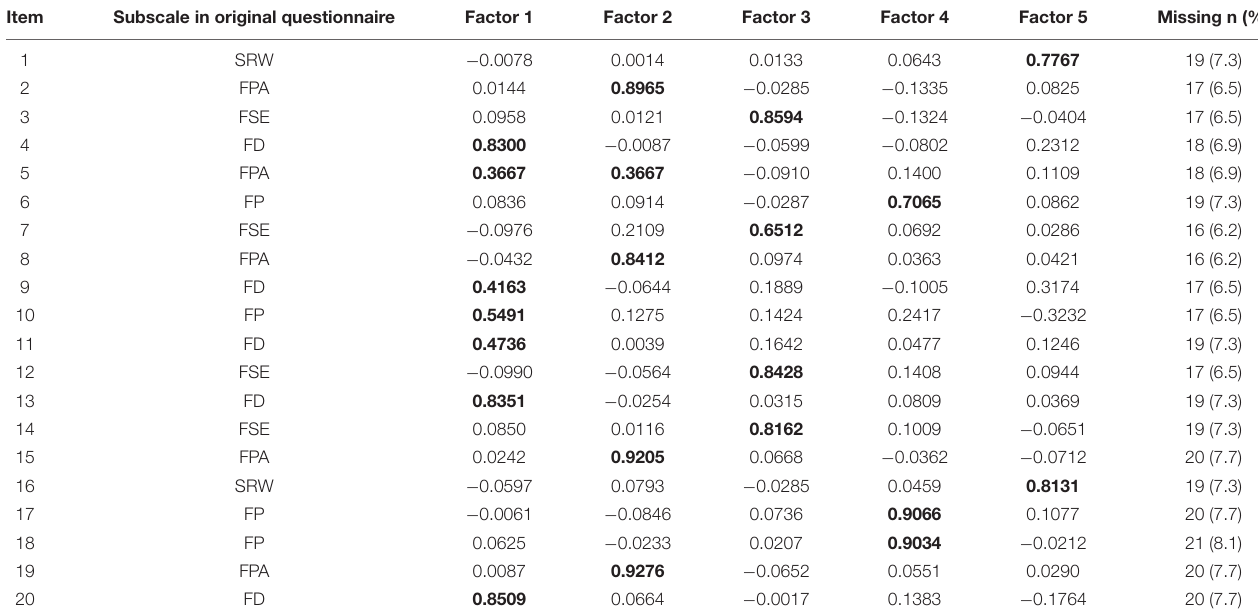
TABLE 3 | Factor loadings of items from the chronic obstructive pulmonary disease-anxiety questionnaire revised – Danish version